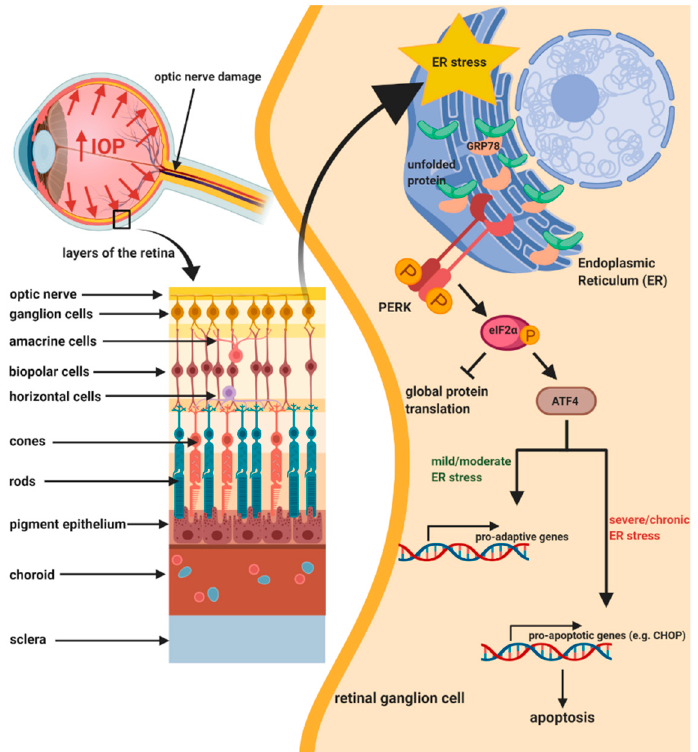
Figure 3. Activation of the protein kinase RNA-like endoplasmic reticulum kinase (PERK)-dependent UPR signaling pathway within retinal ganglion cells (RGCs). POAG pathogenesis, on the molecular level, is correlated with the accumulation of aberrant proteins, such as mutant myocilin, within the ER lumen, which evokes ER stress conditions within the RGCs, subsequent significant elevation of the intraocular pressure (IOP) and activation of the PERK-dependent unfolded protein response (UPR) signaling pathway. Under mild to moderate ER stress conditions, UPR has a pro-adaptive role, whereas severe or long-termed ER stress conditions trigger activation of the pro-apoptotic branch of the UPR, directly leading to RGCs’